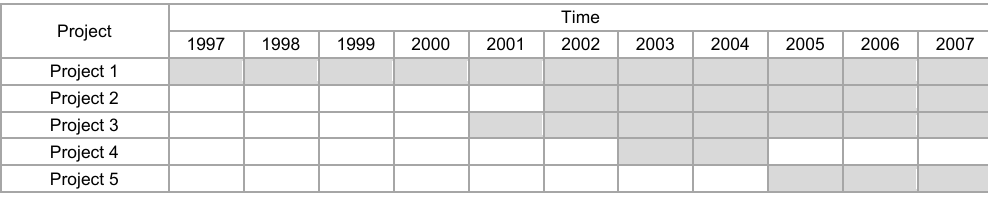
Chronologies of projects with different boundary